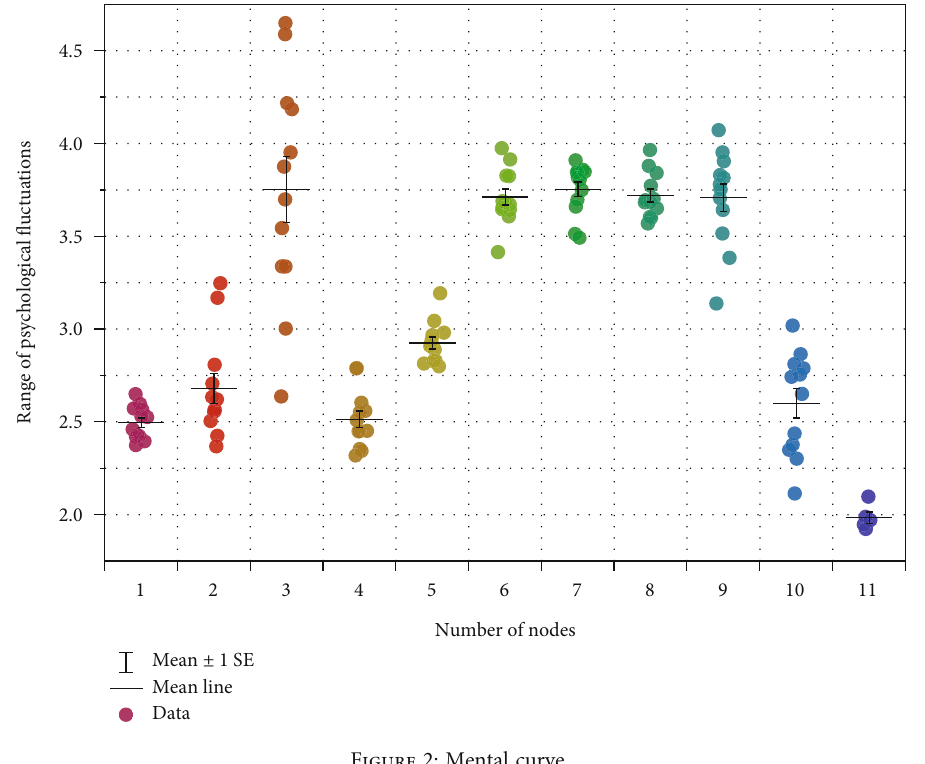
Figure 2: Mental curve.